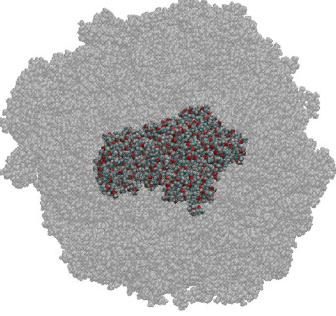
Figure 10. Snapshot of PMMA (gray) and the central part of the PMMA considered for calculation of absorbed CO 2. This snapshot shows the volume that was used to calculate the parameters of sorption according to Equation 14 at various simulation times.